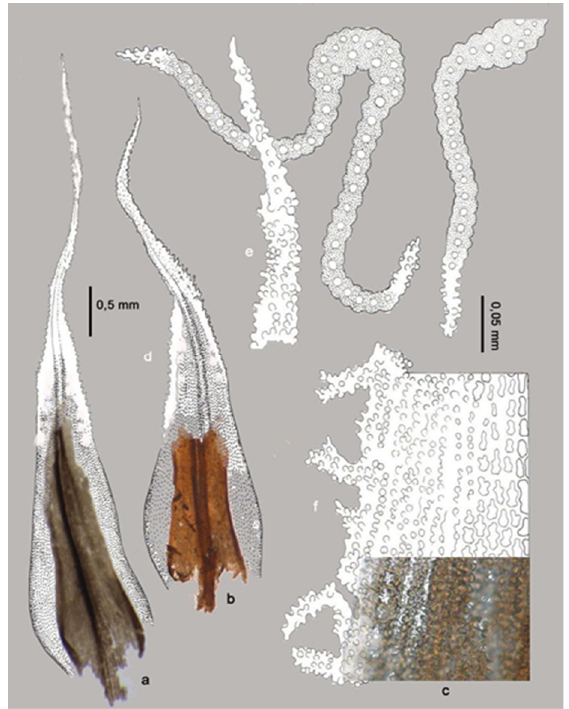
Figure 3. Example of di ff erential degradation in Racomitrium. lanuginosum : ( a,b ) central parts of fossil leaves, ( c ) mid-leaf cells (fossils), ( d,e,f ) current leaves, hyaline apex and papillary rim (Souto, 2018)